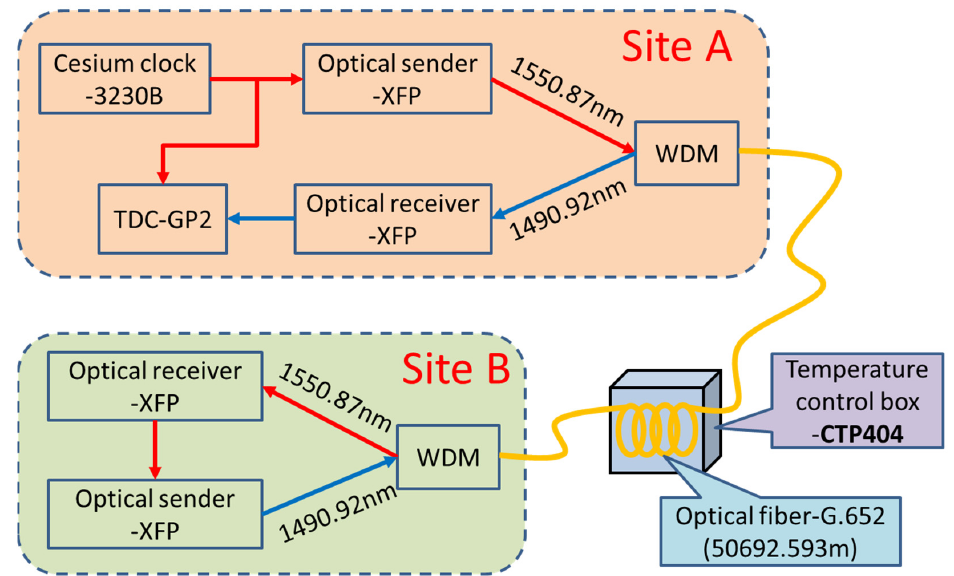
Figure 3. Experimental block diagram of the experimental platform.